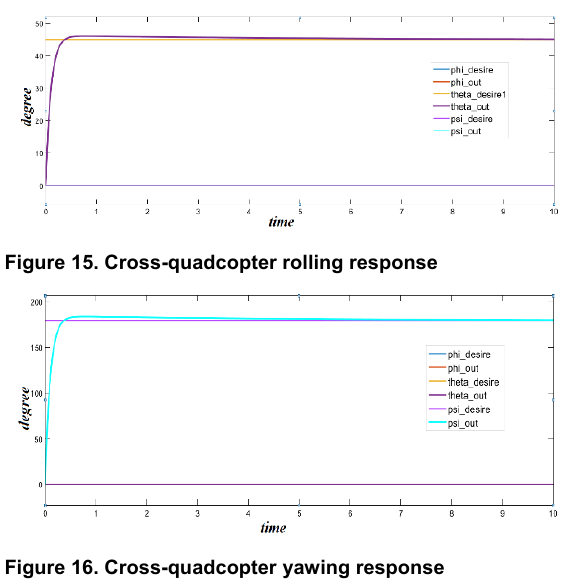
Figure 14. Cross-quadcopter pitching response